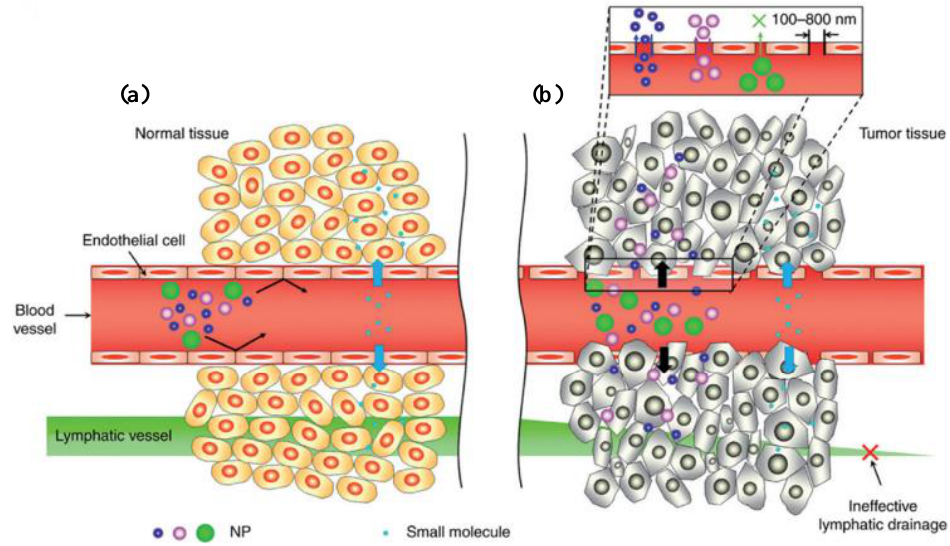
Figure 3. Physiopathological characteristics and passive accumulation of NPs and small molecules in ( a ) healthy tissues ( ≤ 8 nm) and ( b ) tumor tissues (40 nm to 1 μm), mainly due to the EPR effect [25]. Reprinted with permission from ref. [25]. Copyright 2017 Elsevier.